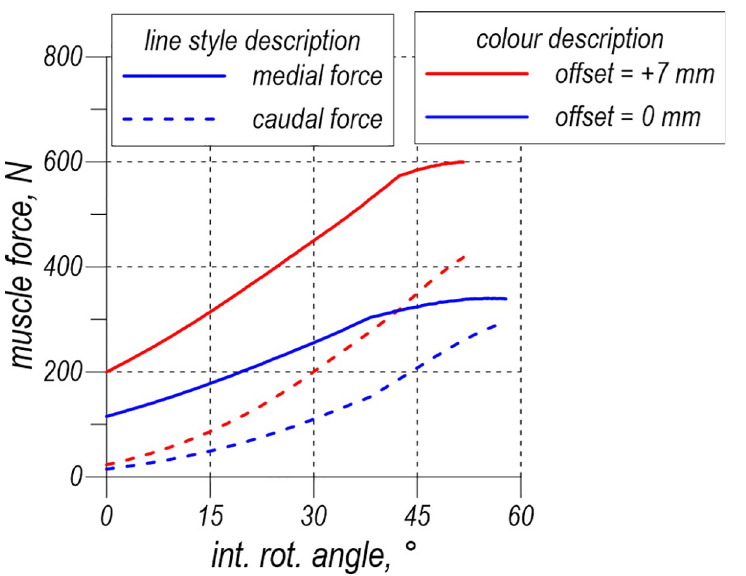
Fig 9. Force analysis for the quadratus femoris.